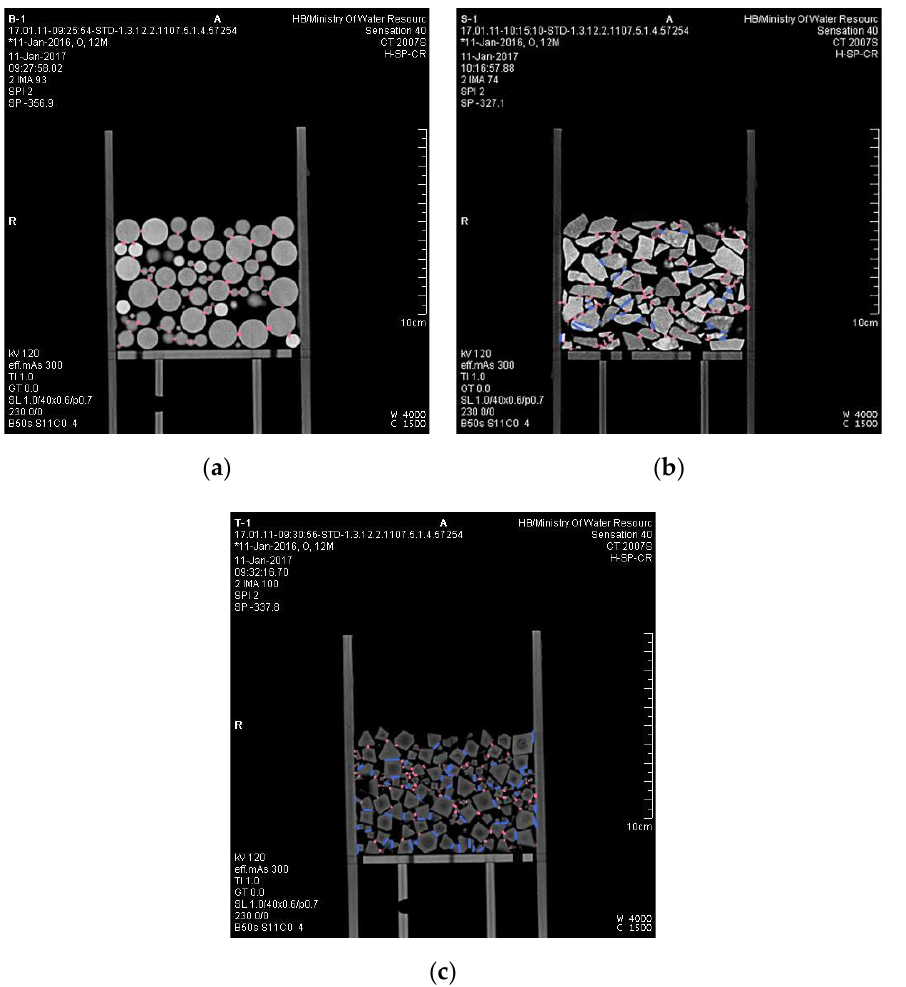
Figure 13. Contact markers on CT images. (a) CT middle section of B1. (b) CT middle section of S1. (c) CT middle section of O1.